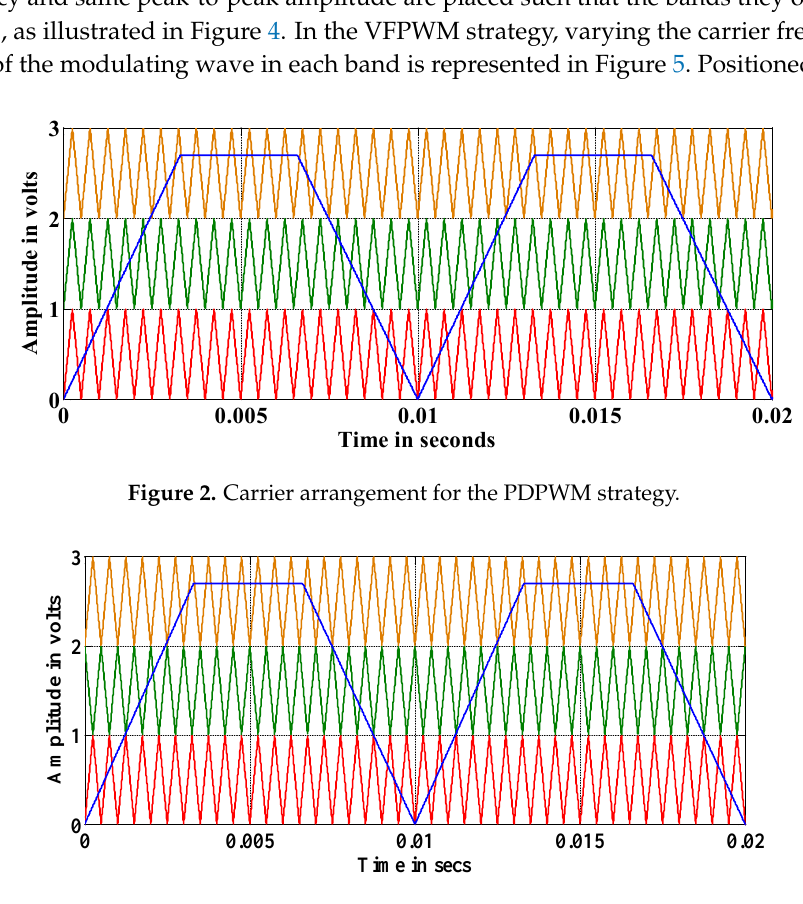
Figure 3. Carrier arrangement for the APODPWM strategy.